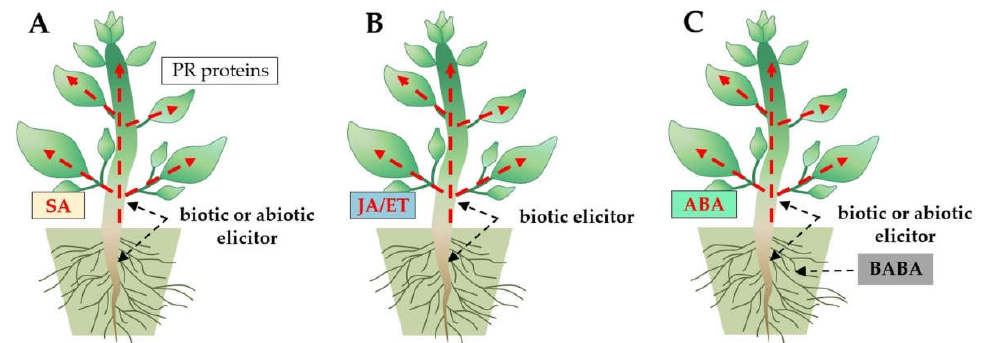
Figure 6. Three types of induced resistance in plants: ( A ) systemic acquired resistance (SAR), ( B ) induced systemic resistance (ISR), and ( C ) induced resistance (IR), trigged by Trichoderma species (biotic elicitor). Signaling molecules, such as phytohormones salicylic acid (SA), jasmonic acid (JA)/ethylene (ET), and abscisic acid (ABA), are involved in SAR, ISR, and IR immunity, respectively. The increase in the plant resistance marker’s (enzymes and metabolites) activity, as a result of the action of Trichoderma elicitors, indicates the induction of signaling pathways of the plant’s defense response. The inoculation of wheat seeds with Trichoderma TkZ3A0 strain conidia significantly increased the activity of the phenylalanine (PAL) and